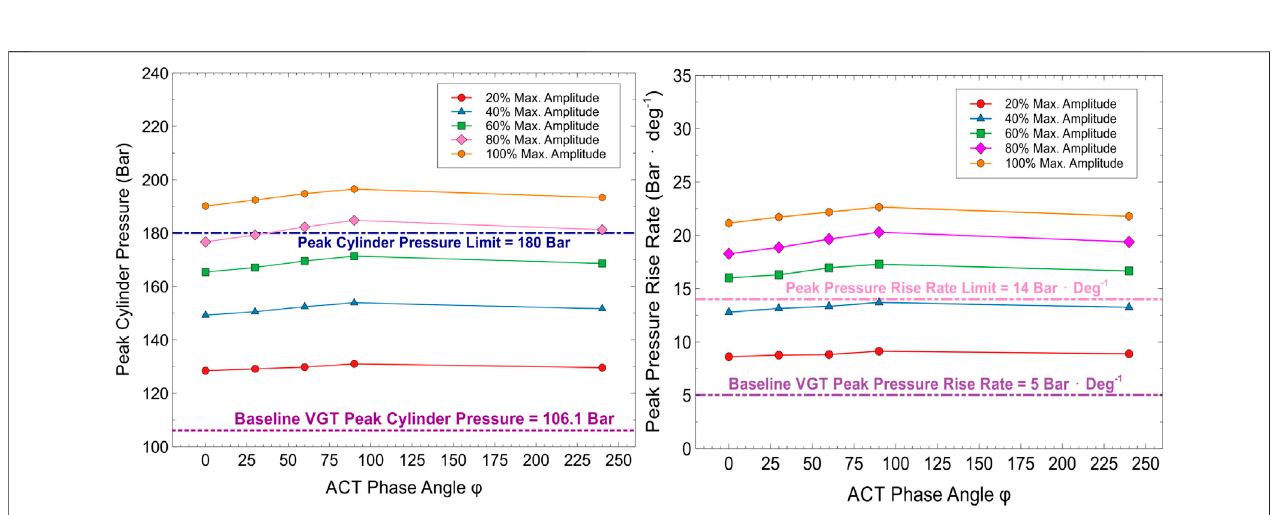
FIGURE 7 | Impact of ACT amplitude and phase angle on (left) : in-cylinder pressure and (right) : heat release rate. Amplitude appears to have a bigger impact on pressure and heat release rate than phase angle.